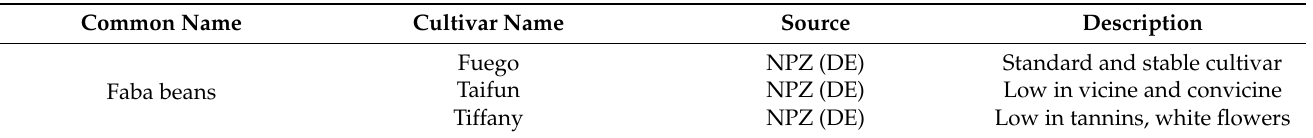
Table 1. Description of the faba bean cultivars of studied traits.